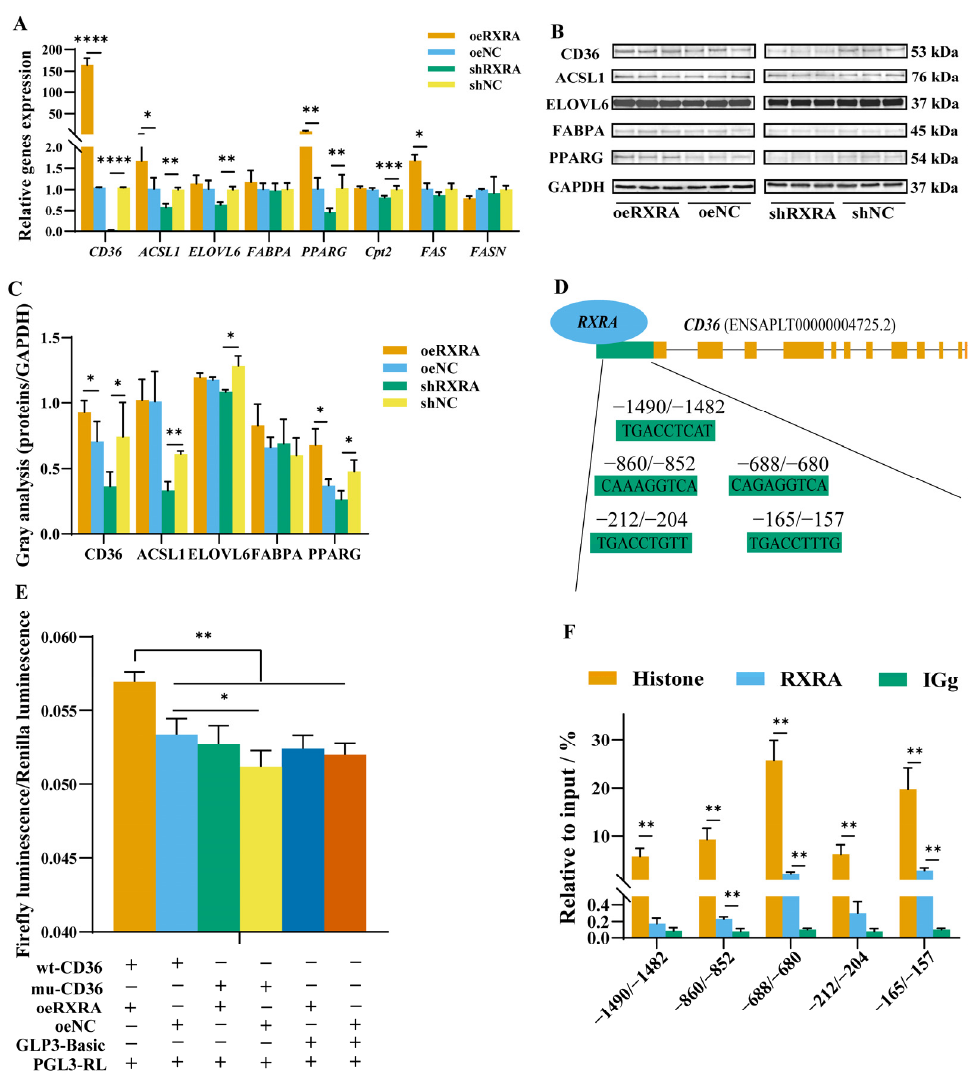
Figure 3. Effect of RXRA on lipid metabolism-related gene and protein expression in myoblasts. ( A ) The gene expression levels of CD36, ACSL1, ELOVL6, FABPA, PPARG, Cpt2, FAS, and FASN after the transfection of overexpression vectors oeRXRA and oeNC and short hairpin (interference) vectors shRXRA and shNC in CS2 cells. ( B ) The indicated protein levels were detected by western blotting. ( C ) The relative changes in CD36, ACSL1, ELOVL6, FABPA, and PPARG expression (protein/GAPDH) in the western blots were quantified by the gray scale scan and reported as the fold change. ( D ) Prediction of RXRA-binding sites in the CD36 promoter region. ( E ) Analysis of firefly luciferase activity and Renilla luciferase activity. ( F ) CHIP analysis of transcription factor RXRA binding to CD36 promoter target sites. The data are reported as the mean ± SD on the basis of three experiments. * indicates p < 0.05, ** indicates p < 0.01, *** indicates p < 0.001, and **** indicates p <